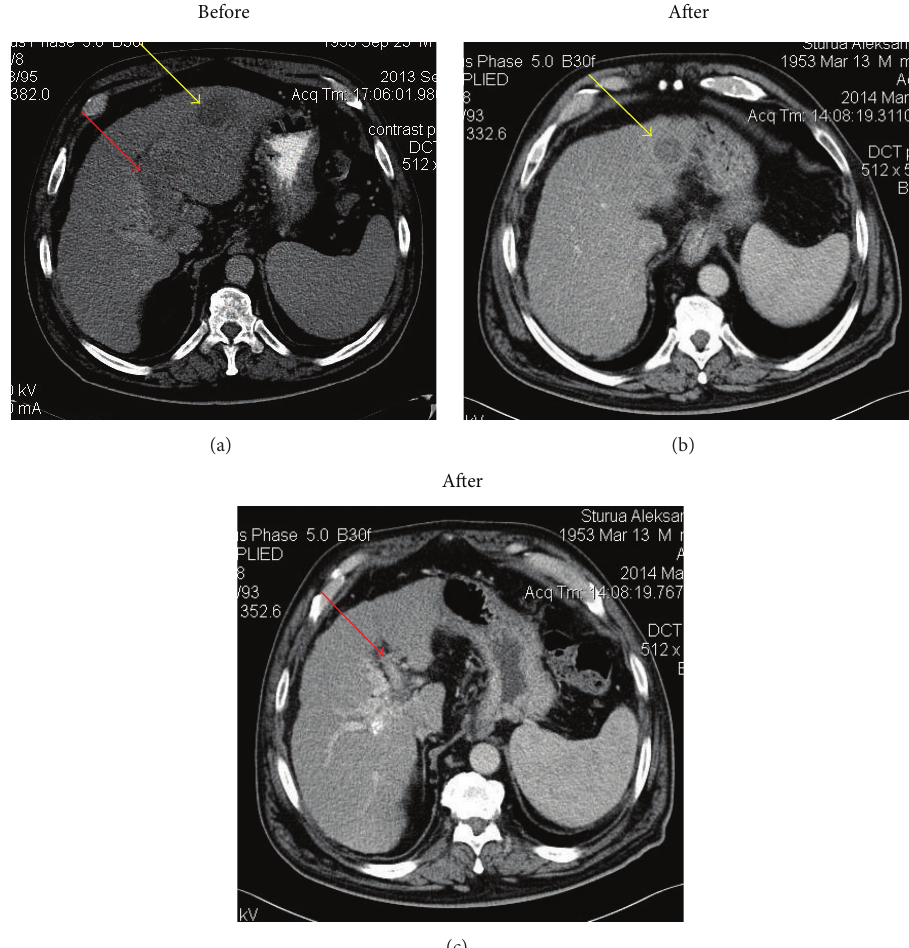
Figure4:Comparison:CTbeforeandin5monthsafterVesOpenprocedure.LPV(redarrow)isrecanalized.Theresidualtumorisrepresented only by hypodense component, the size of which is decreased (yellow